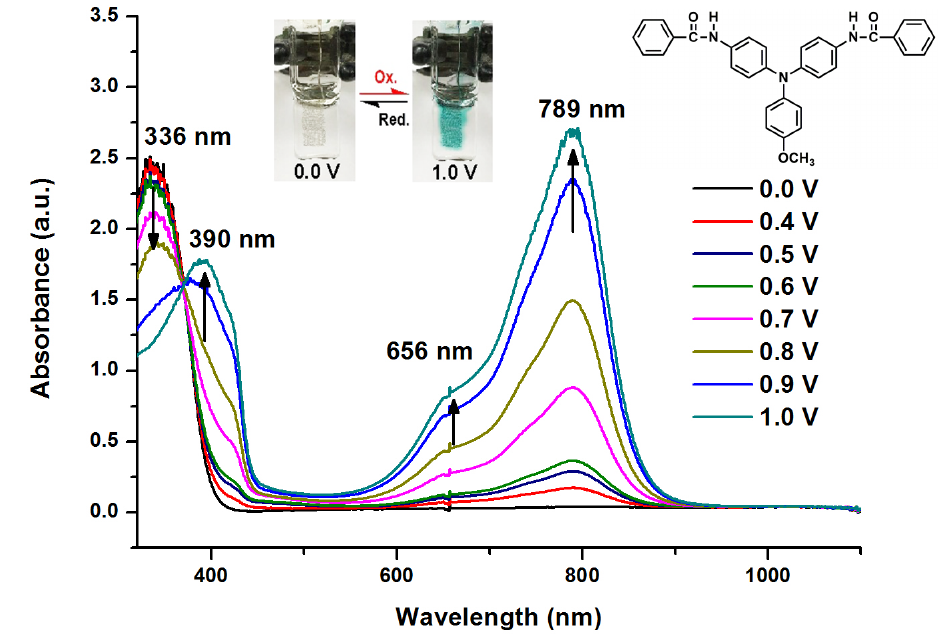
Figure 4. Spectroelectrochemistry of 1 × 10 −3 M model compound MeOTPA-(Ph) 2 in 0.1 M Bu 4 NClO 4 /CH 2 Cl 2 .